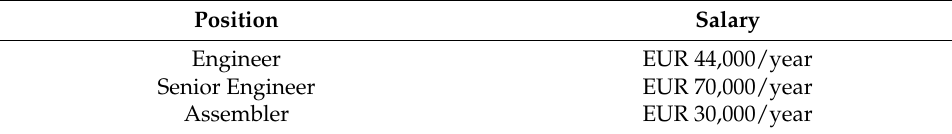
Table 3. Estimated salaries [19] used for cost items determination in Table 2. Position Salary Engineer EUR 44,000/year Senior Engineer EUR 70,000/year Assembler EUR